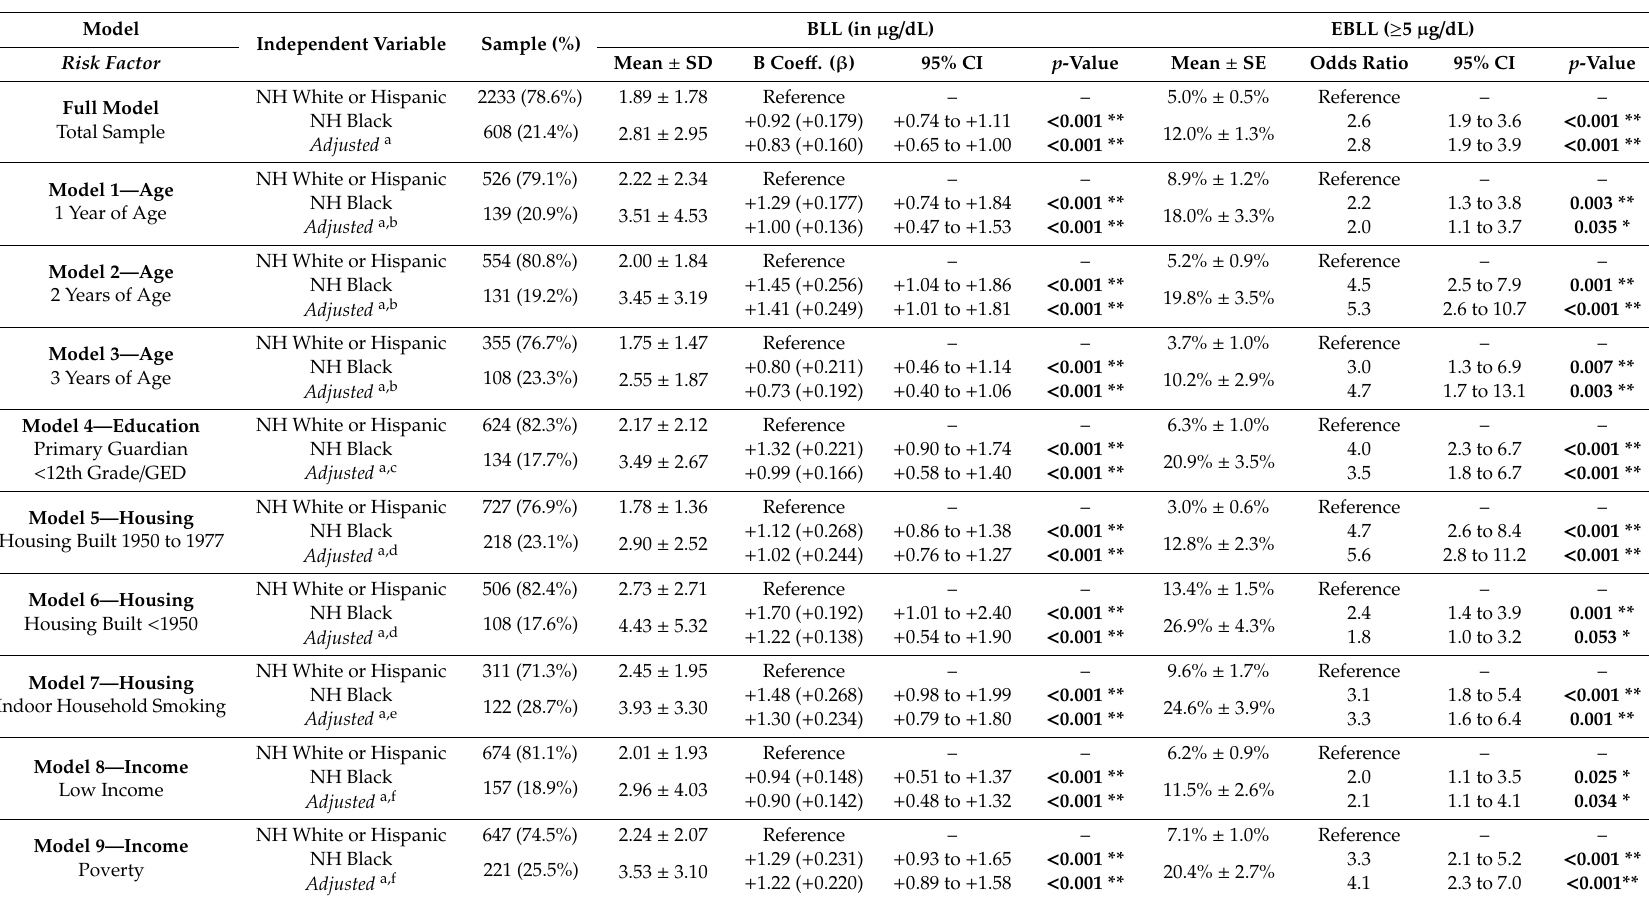
Table 3. Racial disparities in blood lead (Pb) level outcomes for risk factor groups of early childhood Pb exposure before and after correcting for covariates in multiple regression model analysis—the 1999 to 2010